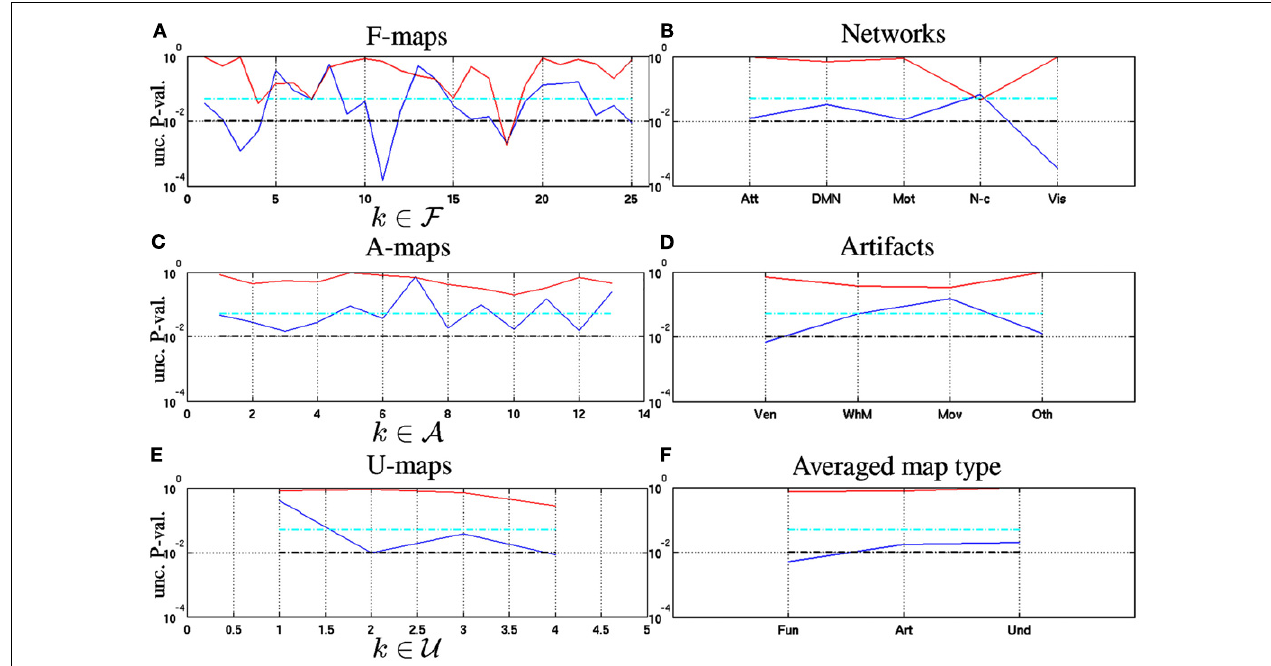
FIGURE 7 | Uncorrected p-values associated with two-samples respectively. Similar tests were computed at a broader spatial scale on the Student-t test performed between resting-state and task-related functional networks (B) , the artifacts (D) and the averaged map types (F) , multifractal parameters for assessing (cid:2) H ( 1, · ) respectively. Significance levels ( α 1 = 0.01 and α 2 = 0.05) are shown in - - (blue curves) and (cid:2) H ( 2, · ) (red 0 0 curves) on the functional (A), artifactual (C) and undefined maps (E), and - -,